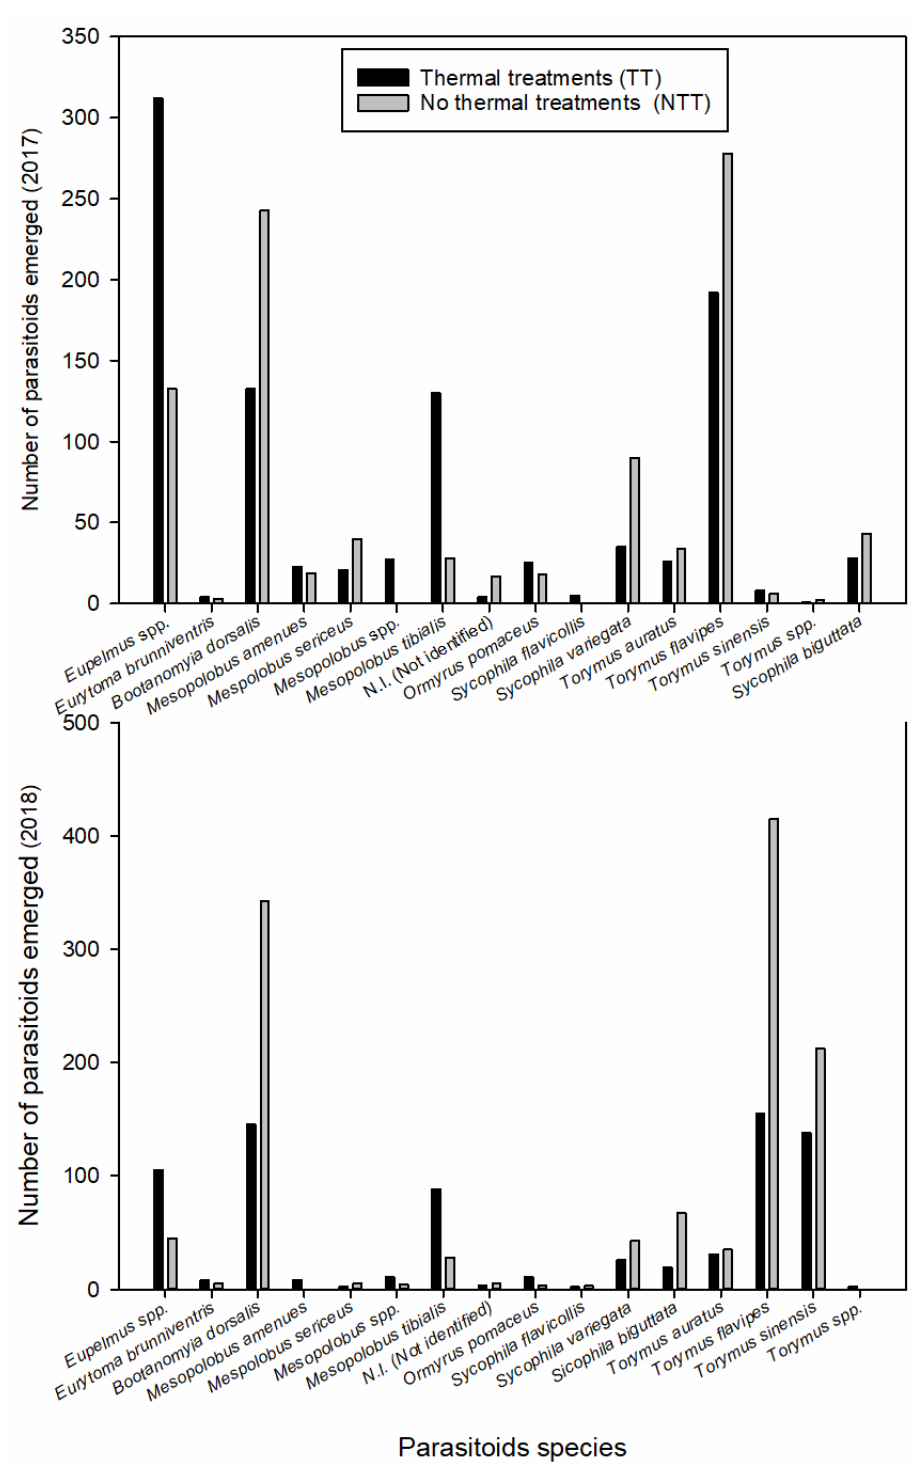
Figure 3. Parasitoid species that emerged from galls in different treatment groups from the three monitored chestnut fields ( A , B , and C ). The data from the three fields were pooled by year.